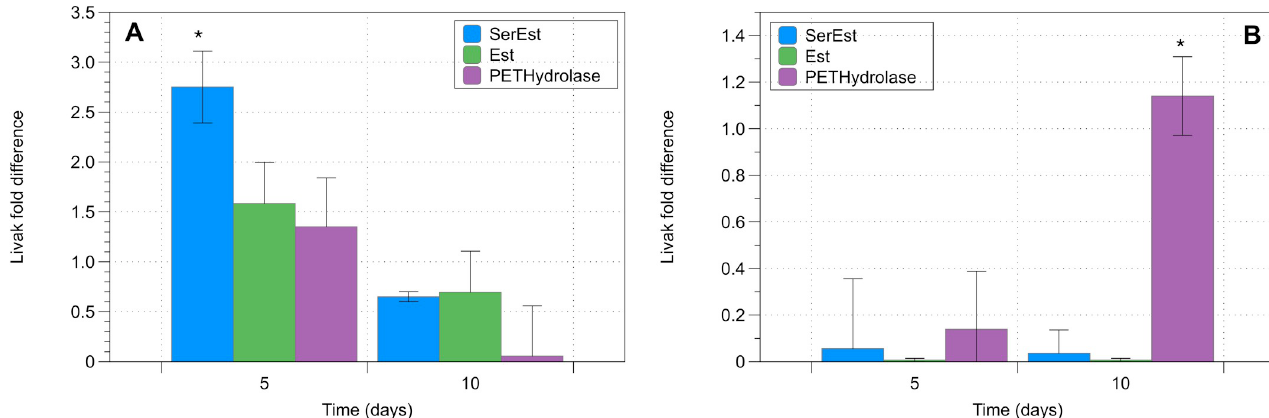
Fig 7. Comparison of transcript expression of selected hydrolase and lipase genes as measured by RT-PCR analysis of samples exposed to polyethylene particles. Normalized fold expression of selected genes relative to a control sample (time point = day 0). All genes were analyzed in triplicate by RT-PCR. Relative Quantification was carried out using the 2 − ΔΔ CT method. A) Expression analysis for polyethylene nanoparticle samples B) Expression analysis for polyethylene microparticle samples. Data = mean +/SEM; N = 3; � p < 0.05 �� p < 0.01.